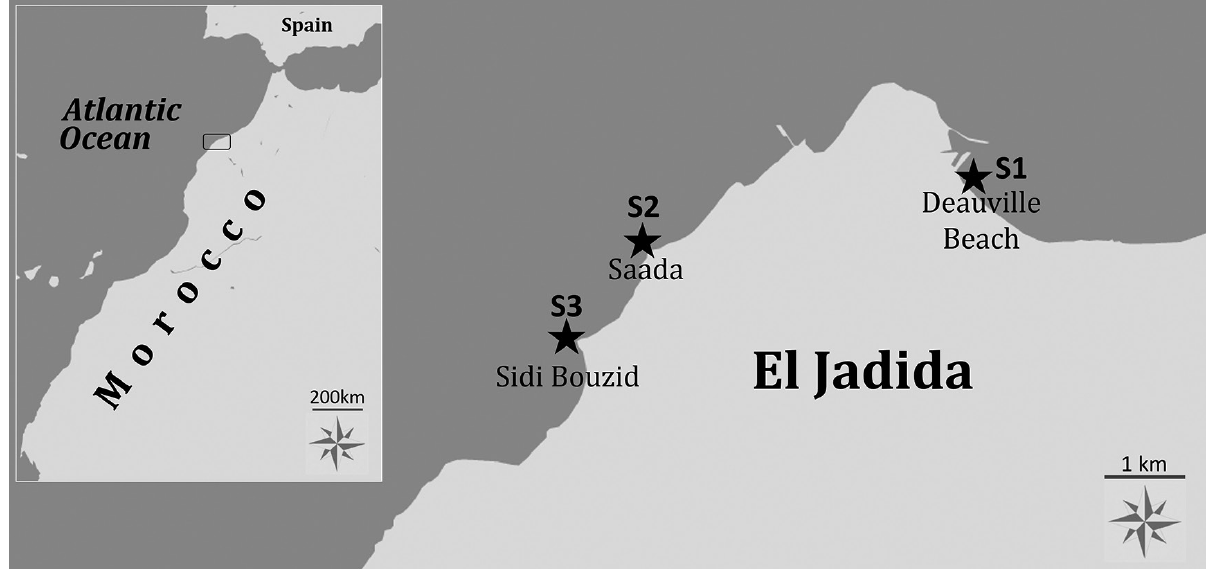
Fig. 1. – Geographical location of the study